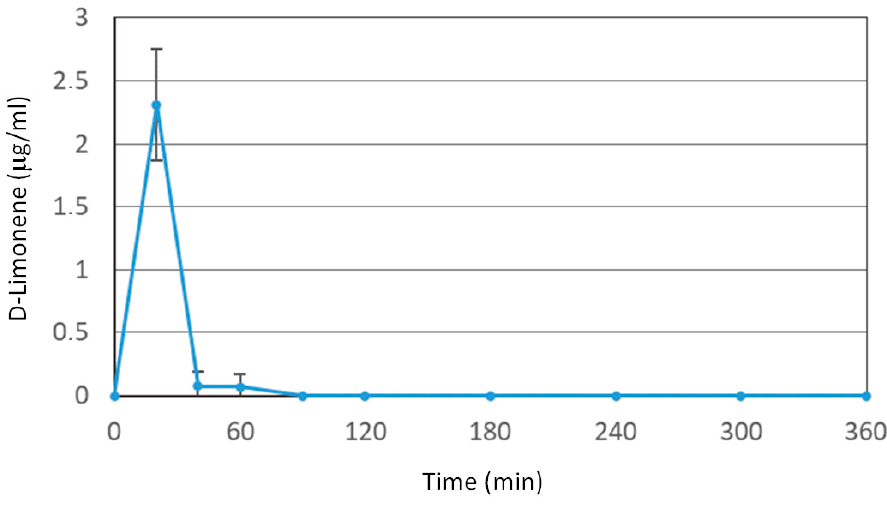
Figure 1. Blood D-Limonene concentrations (µg/mL) within 360 min after oral administration of a a 50 mg dose (i.e., 200 mg/kg) to rats. Data are expressed as the mean ± SE of four independent 50 mg dose (i.e. , 200 mg/kg) to rats. Data are expressed as the mean ± SE of four independent exper- iments. The oral formulation consisted of D-Limonene dissolved in corn oil. experiments. The oral formulation consisted of D-Limonene dissolved in corn